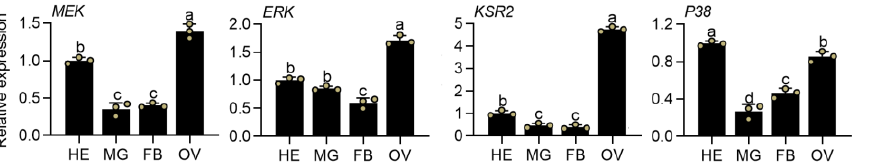
Figure 2. The expression patterns of MEK , ERK , KSR2 , and P38 in female C. bowringi. At 4-day PE, qRT-PCR was used to detect relative expression, and the levels of expression in the midguts (MG), fat bodies (FB), and ovaries (OV) were compared to those in the heads (HE). All data in the figures were presented as mean ± SD. The different letters above the bars denoted statistically significant differences determined by one- way ANOVA with Turkey’s LSD test (α = 0.05).